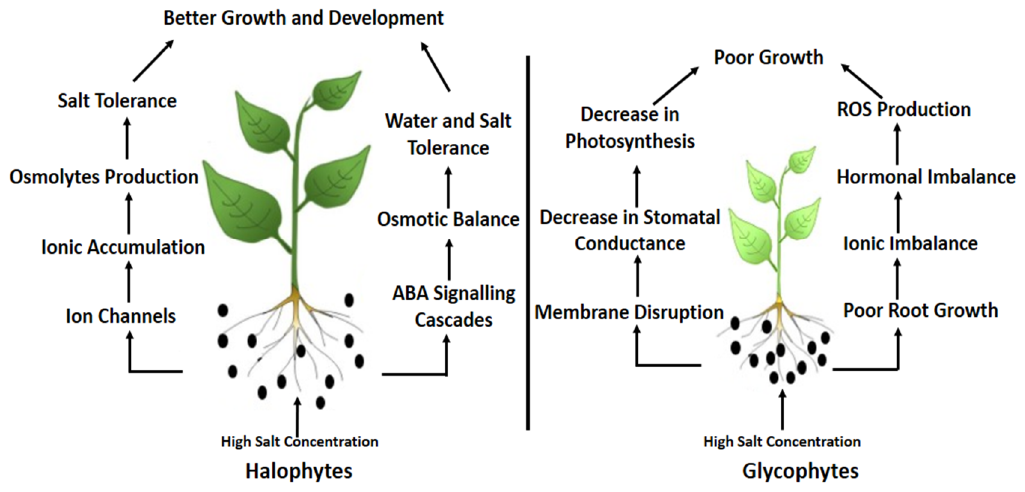
Figure 2. Regulation of physiological and biochemical process in halophytes through ionic compartmentalization, osmotic adjustment, enzymatic activities, polyamines, and stress signaling regulation.